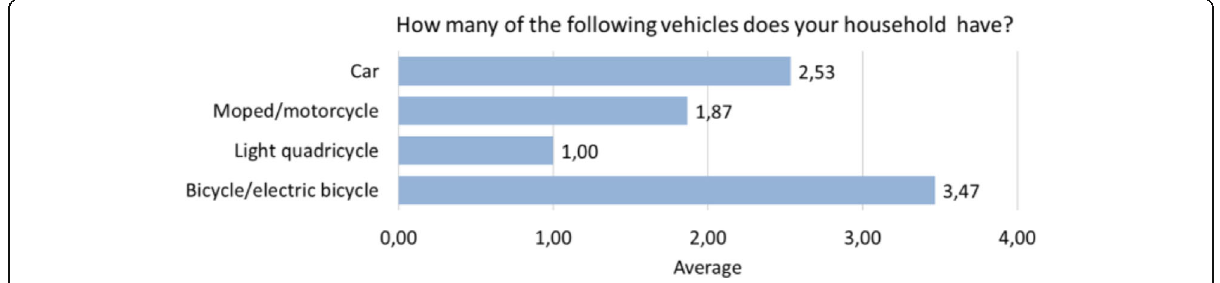
Fig. 5 Average number of vehicles per household in the Porvoo pilot area ( n =